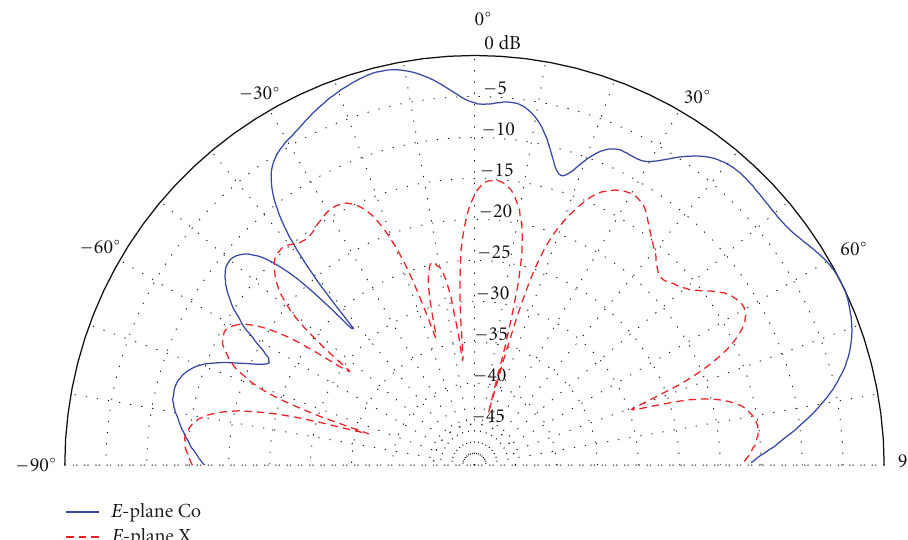
Figure 10: E-plane copolarization and crosspolarization measured at 7.4GHz.